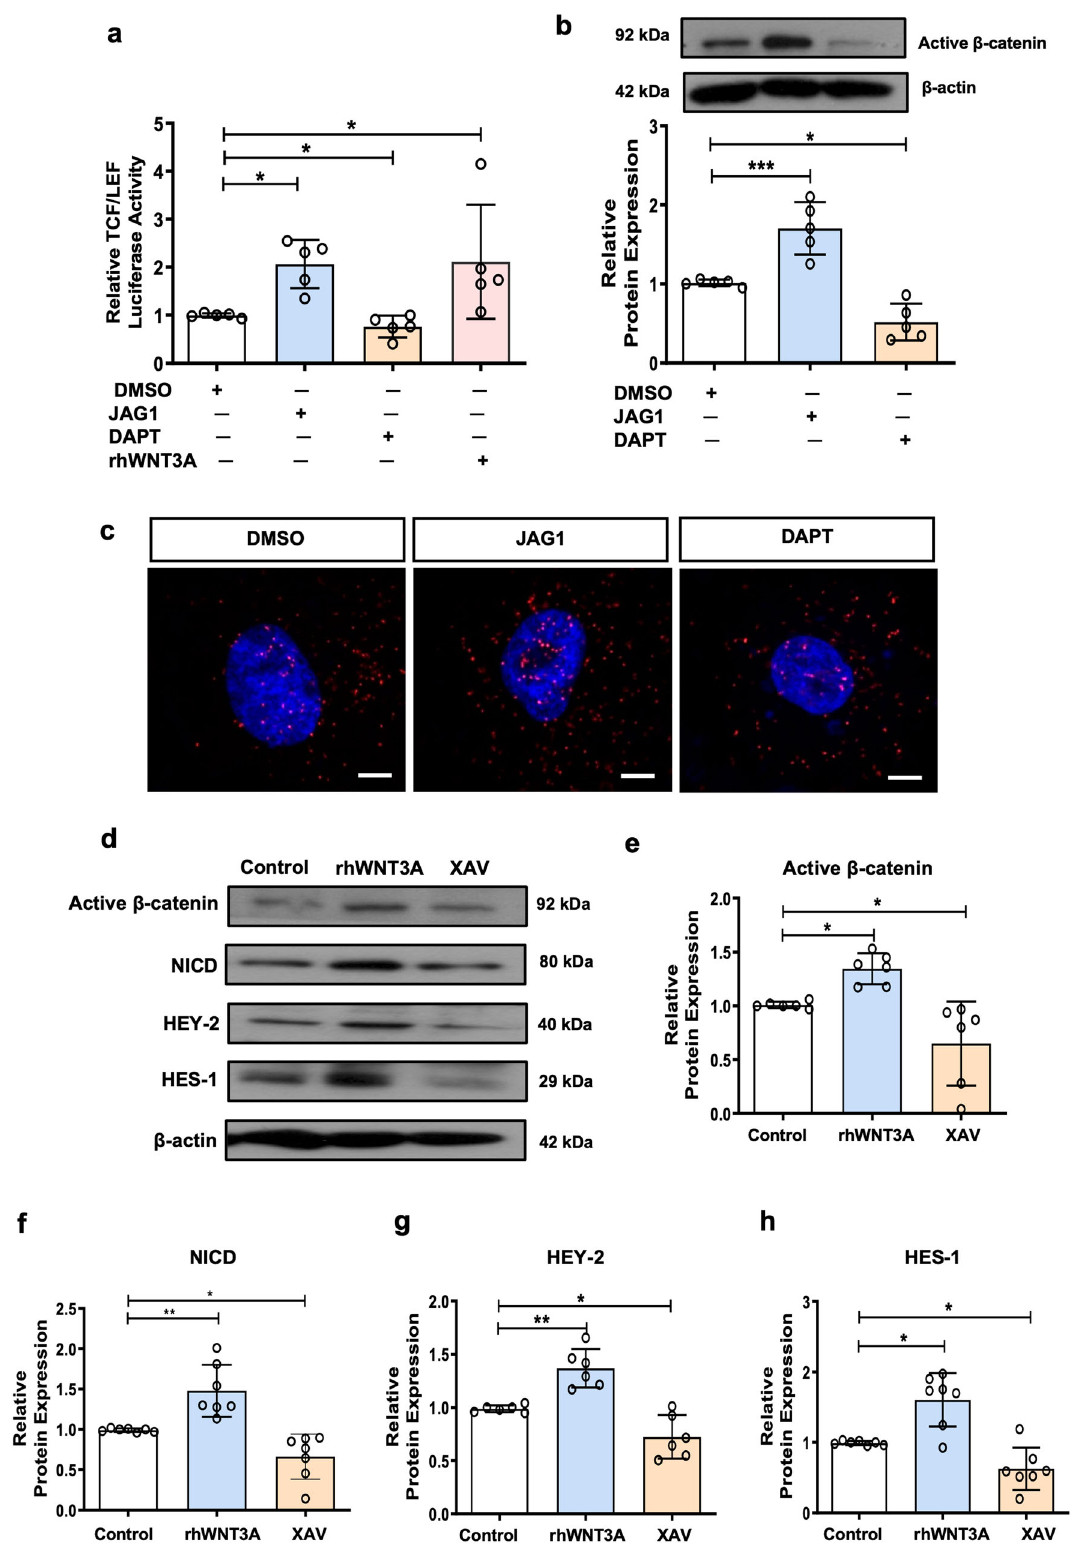
active β -catenin expression in the mouse endometrium after DAPT treatment (Fig. 7h,